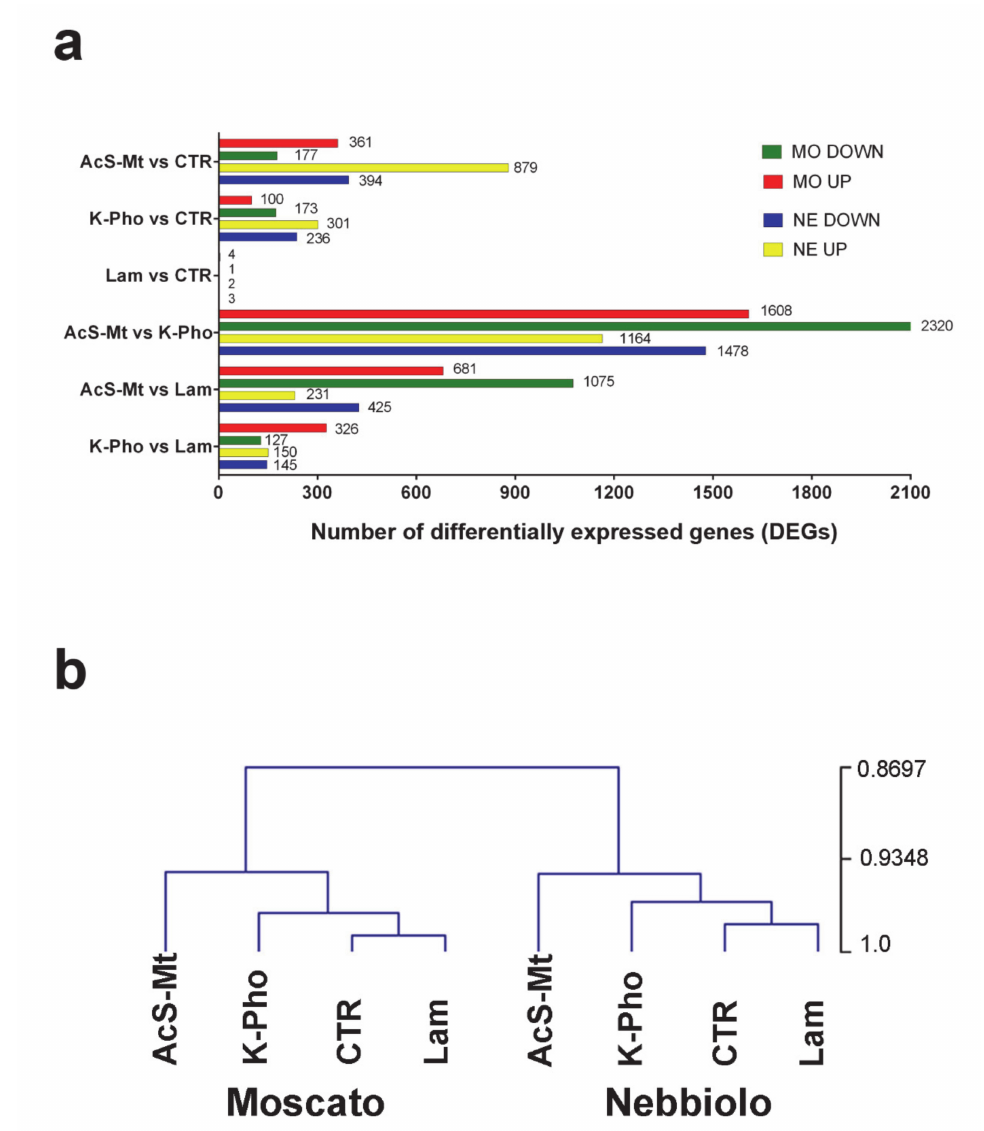
Figure1. Transcriptomeanalysisofleafsamplesobtainedfrom‘Nebbiolo’and‘Moscato’plantsartificially inoculated with Erysiphe necator and then untreated (CTR) or treated with acibenzolar-S-methyl (AcS-Mt), potassium phosphonate (K-Pho), and laminarin (Lam). In ( a ), the total number of differentially expressed genes (DEGs), up (UP) or down (DOWN)-regulated, is shown for each RNAseq comparison beside the bar charts. MO = ‘Moscato’; NE = ‘Nebbiolo’. In ( b ), the dendrogram displays the output of the HCL (Hierarchical Clustering) analysis performed on RNAseq data. The numbers reported next to each node are bootstrap values from 1000